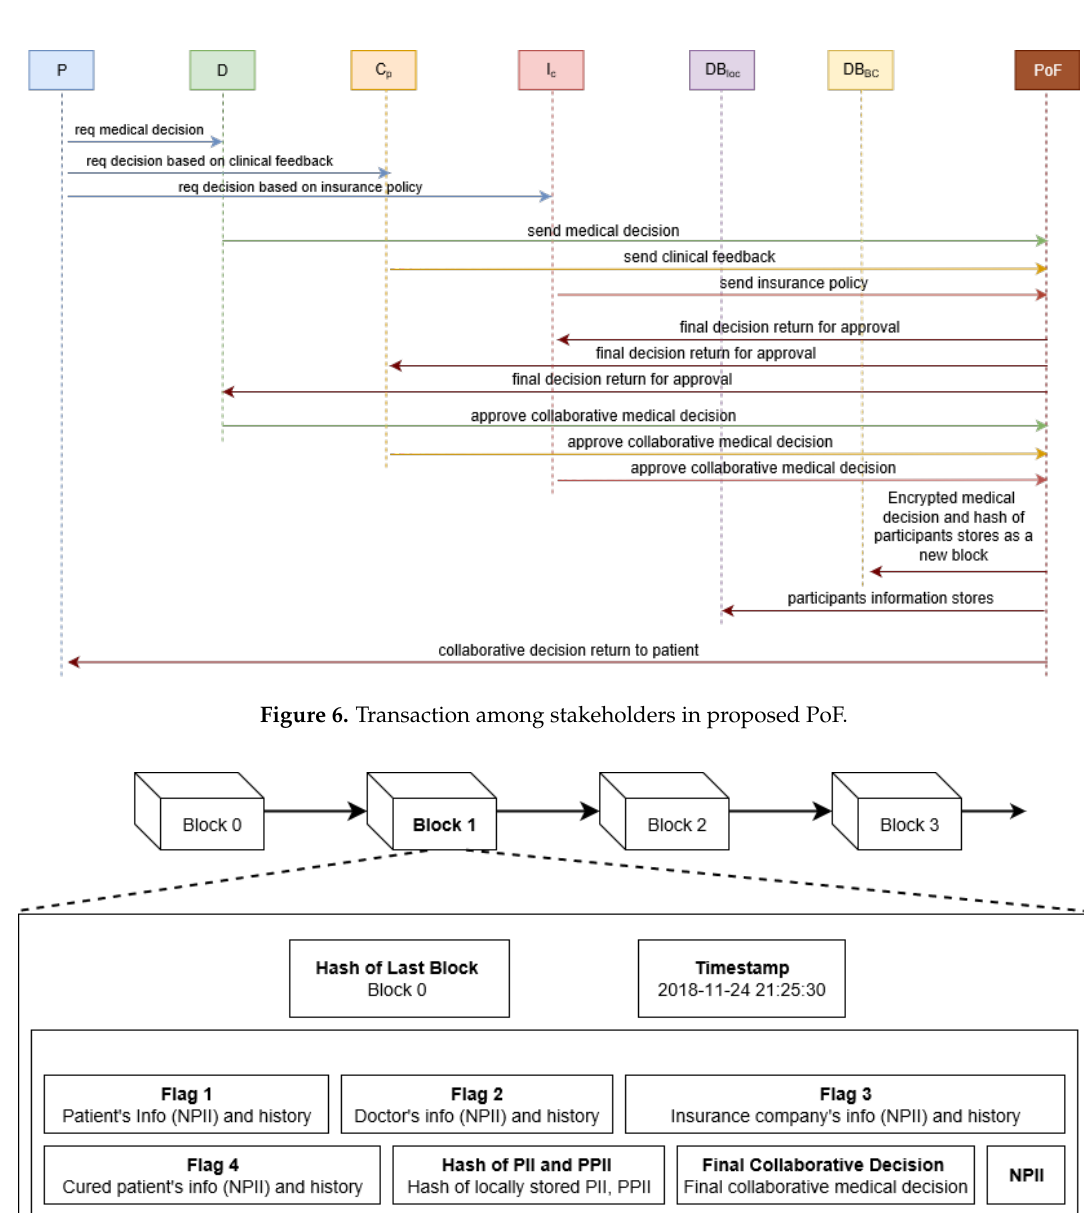
Figure 7. Sample block architecture of the proposed scheme (Block 1).